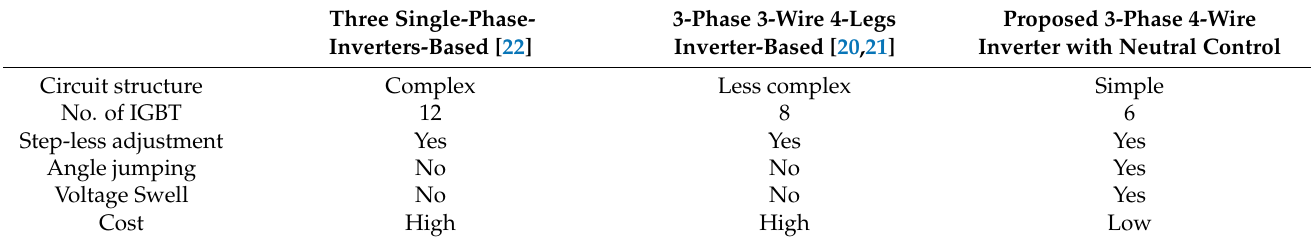
Table 1. Comparison of various voltage sag/swell